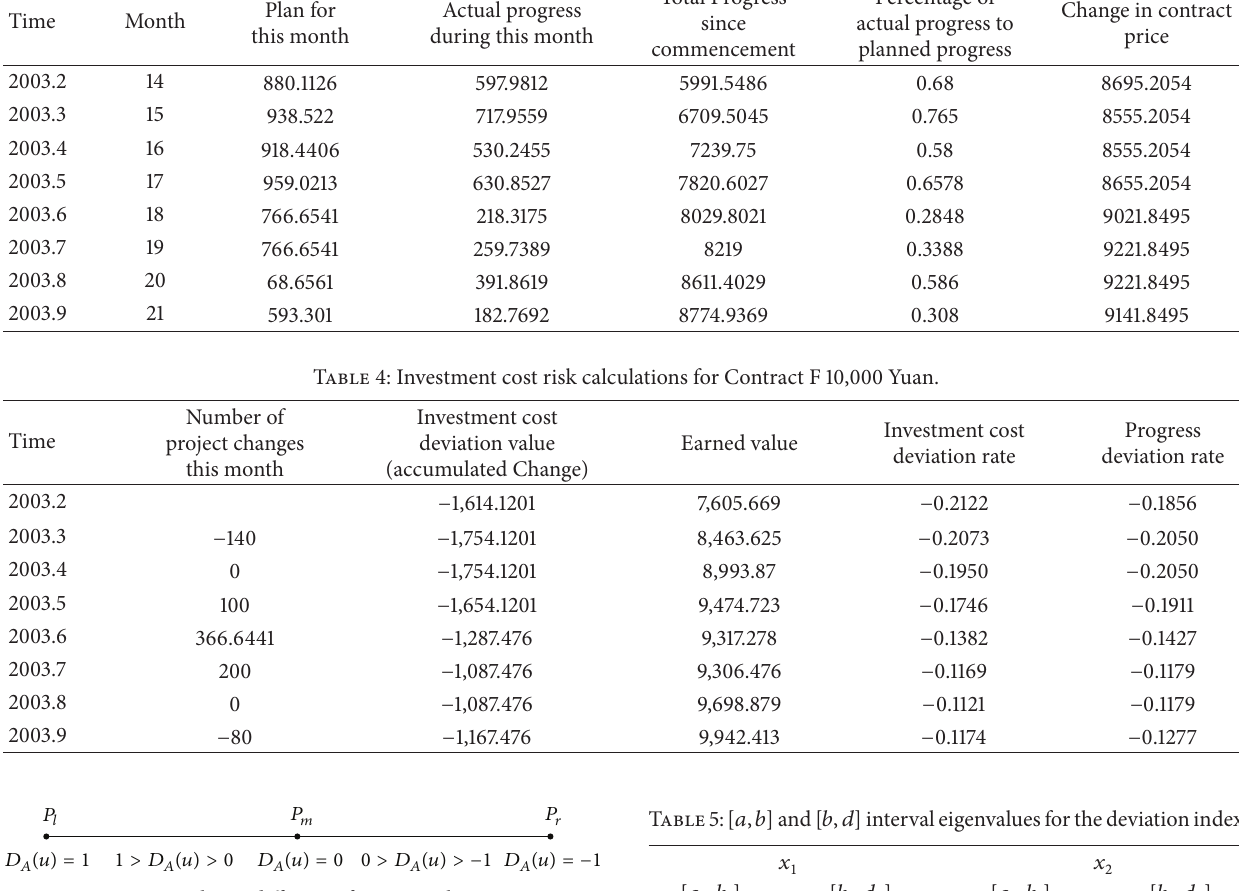
Figure 8: Relative difference function schematic.